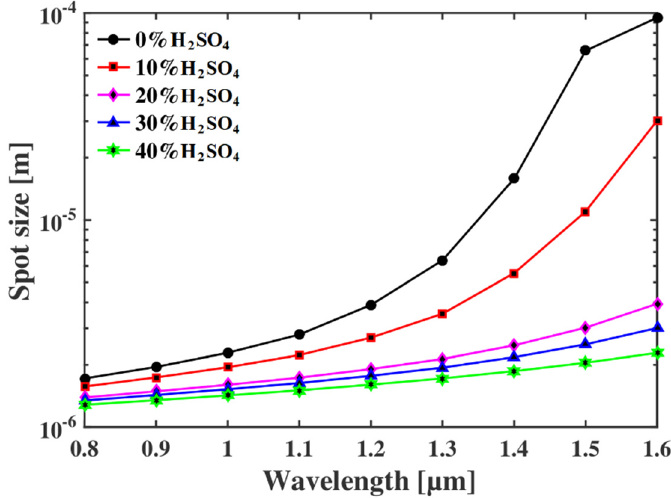
Figure 9. The spot size of the proposed sensor for different operating wavelengths.